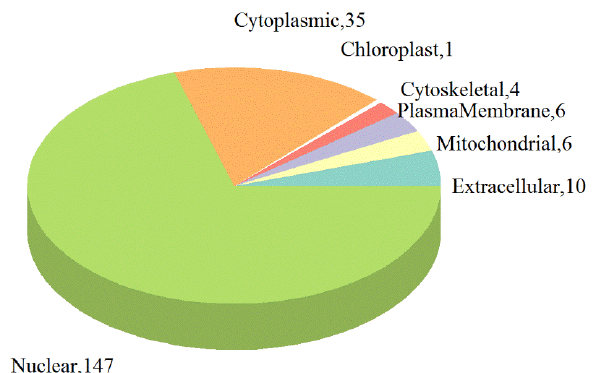
Figure 4. Subcellular locations of the DEPs in PK-15 cells infected with PSV.